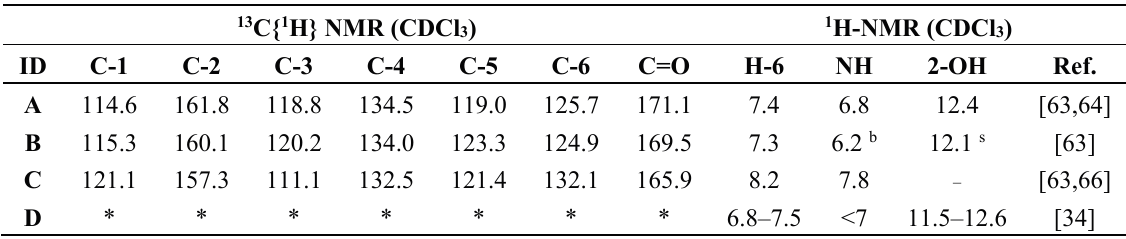
Table 1. Selected 13 C/ 1 H chemical shifts ( δ ) of literature compounds A , B , C , and D